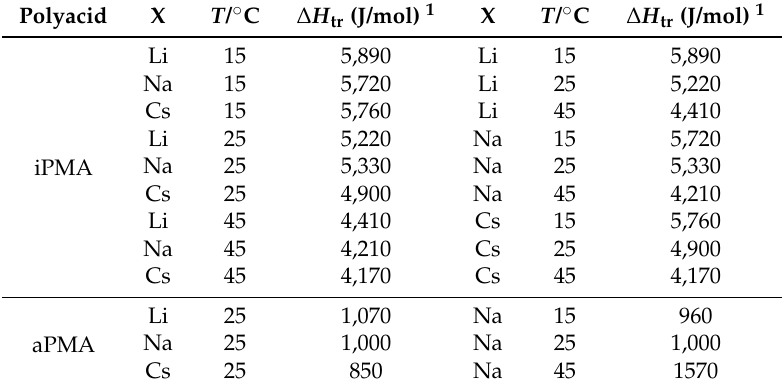
∆ H tr for aPMA (see conf ”